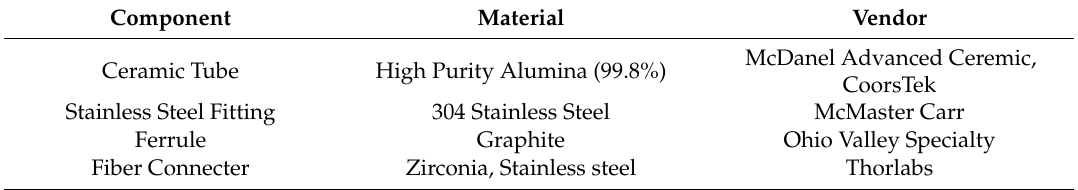
Figure 3. Design and picture of the sensor packaging. Table 1. Description of the Packaging Components.